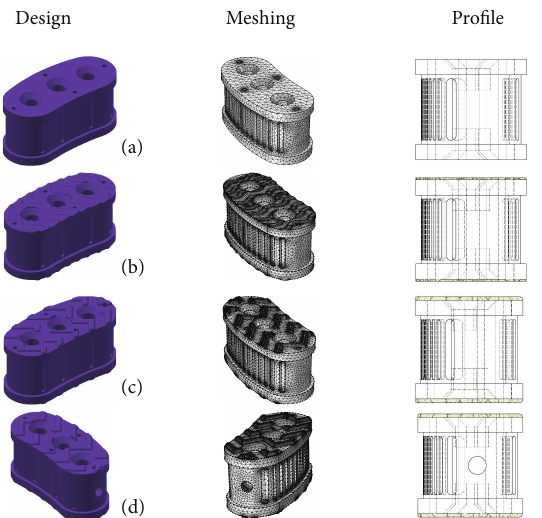
Figure 4: Proposed lumbar cage new designs.